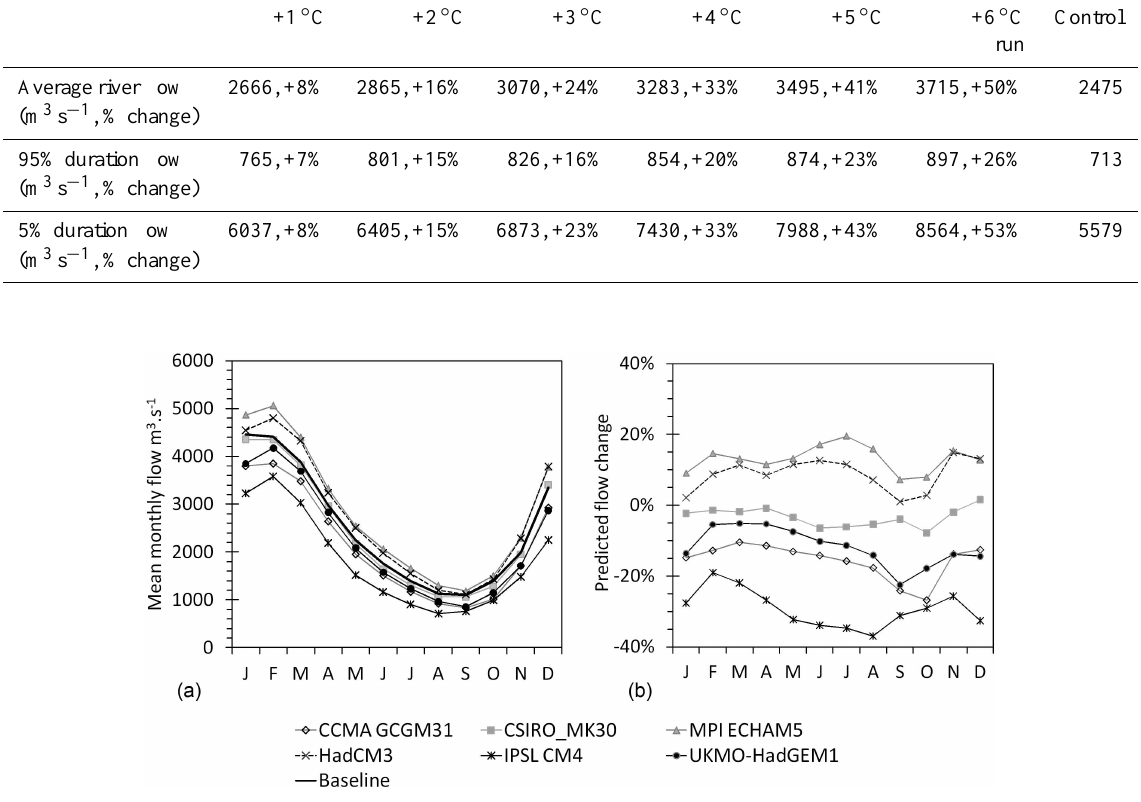
for all durations. For the extreme scenario of +6 ◦ C, the in- crease would be from 5579 m 3 s − 1 in baseline to 8564 m 3 s − 1 for 5% duration and from 713 m 3 s − 1 to 897 m 3 s − 1 for